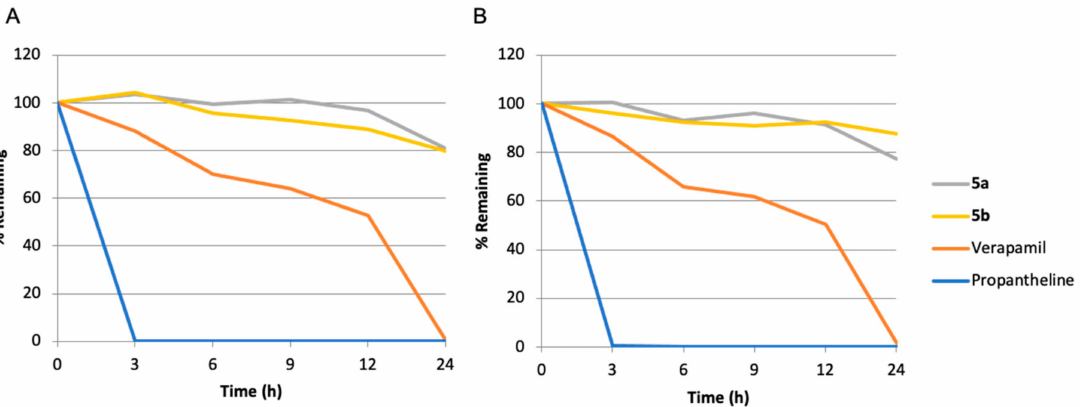
Figure 4. Stability of prodrugs 5a,b in mouse ( A ), and in human ( B )